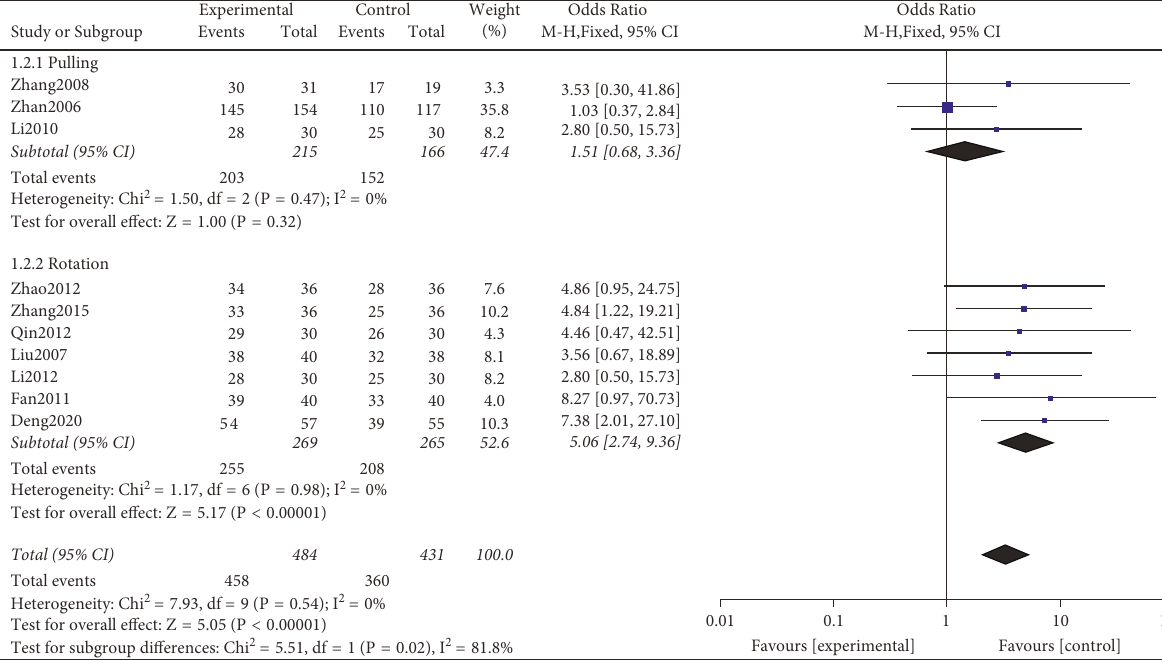
Figure 5: Comparison between the short-term efficacy of manipulation and cervical traction in the treatment of